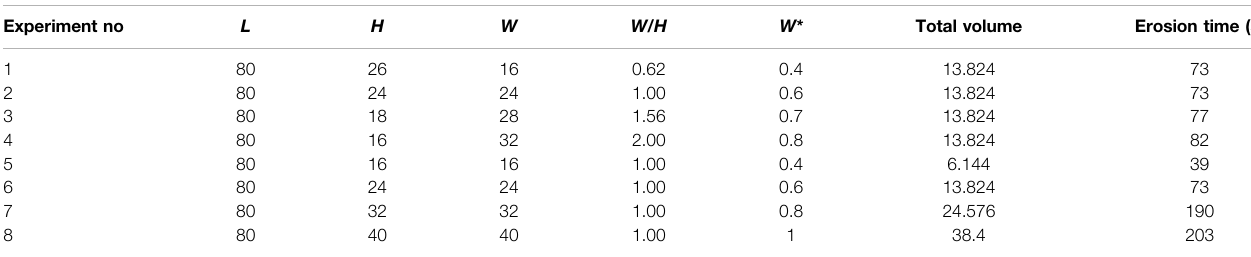
TABLE 2 | The experiment set and results considering the blockage rate W* . Experiment